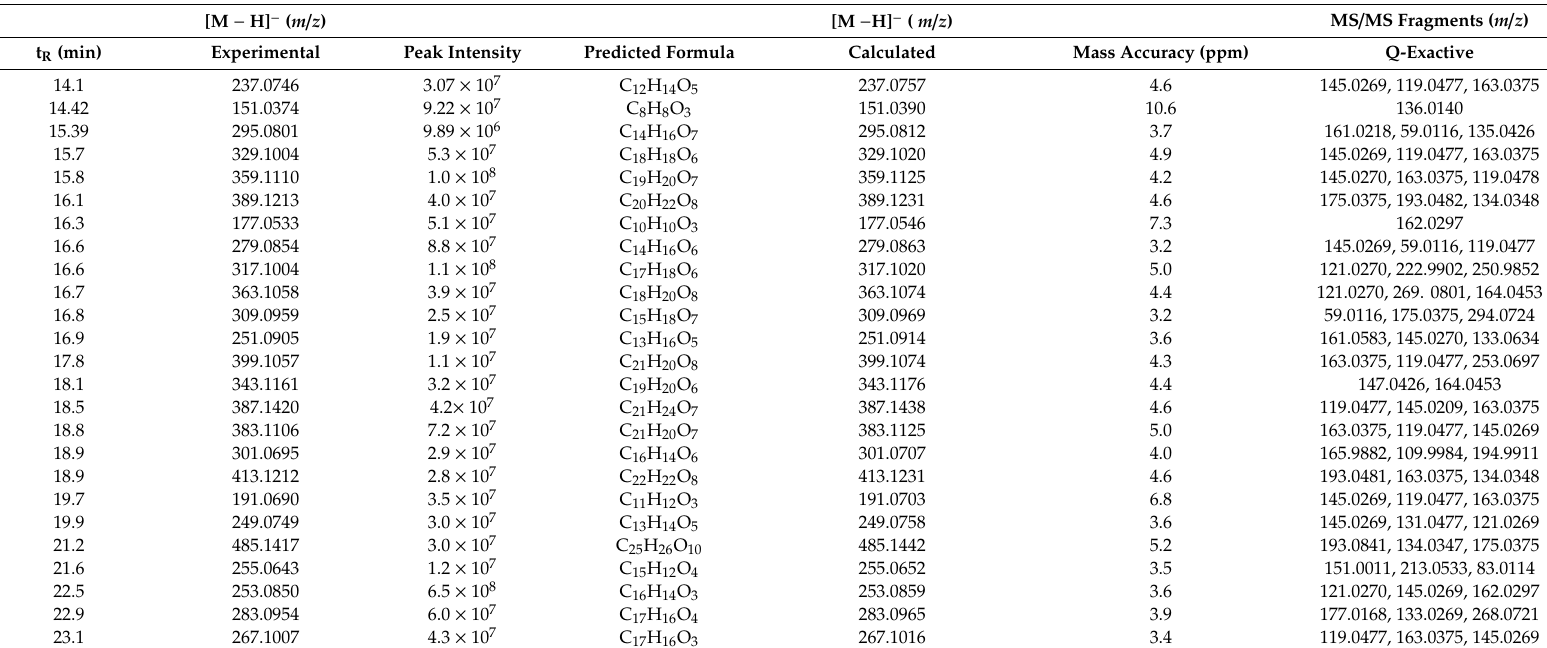
Table 4. Empirical formula assignments for an additional 25 compounds of high abundance in propolis